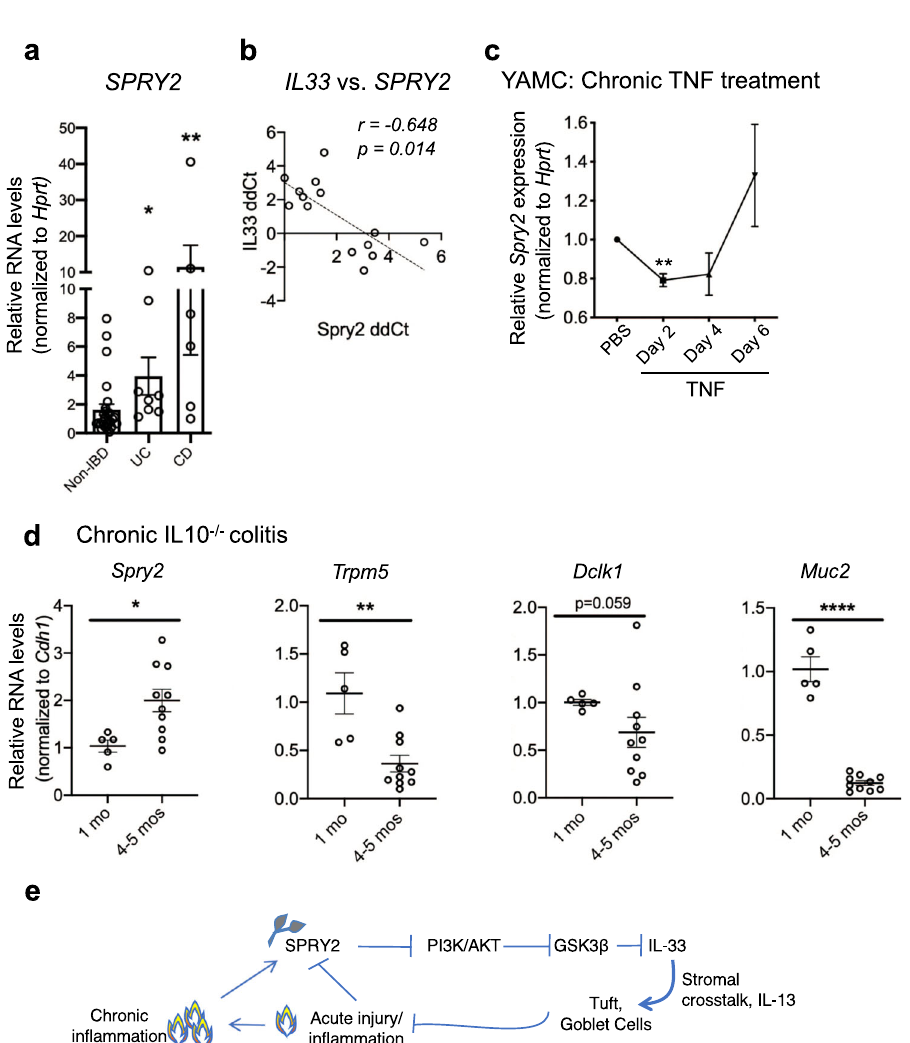
Fig. 8 Sprouty2 is elevated in human IBD, and expression levels negatively correlate with tuft cell markers. a Samples from patient mucosal biopsies from unin fl amed non-IBD ( n = 27), or in fl amed ulcerative colitis ( n = 8) and Crohn ’ s disease ( n = 6), were analyzed for SPRY2 expression; * p < 0.05; ** p < 0.01. Patient characteristics shown in Supplementary Table 1. b Correlation of SPRY2 and IL33 expression levels from IBD patient biopsies (qPCR, plotted as ddCt values). c YAMC cells treated chronically with 100 ng/ml TNF every 2 days for 6 days were measured by qPCR for Spry2 expression; n = 7 independent experiments. ** p < 0.01 versus PBS. d Distal colonic homogenates from IL10 − / − mice before onset of colitis (1 month of age; n = 5) and post- onset of chronic colitis (4 – 5 months of age; n = 10) were assayed by qPCR for Spry2 and markers of tuft and goblet cells. Spry2 , *p = 0.0176; Trpm5 , ** p = 0.0022; Muc2 , **** p < 0.0001. In fi gure, data are presented as mean ± SEM. Analyzed by one-way ANOVA with Dunnett post hoc test, Pearson correlation, or two-sided t test. e Proposed model of Sprouty2 regulation of epithelial IL-33 and secretory cell development in response to colonic in fl ammation: Acute in fl ammation represses Sprouty2 expression in the epithelium. This removes basal inhibition on PI3K/Akt, leading to Akt-mediated inhibition of GSK3 β , promoting epithelial IL-33 expression. Epithelial-produced IL-33 induces IL-13 in the stroma, which in turn signals back to the epithelium to promote tuft and goblet cell expansion as a compensatory mechanism to limit acute in fl ammation and promote injury resolution. Loss of this dynamic differentiation mechanism in the setting of chronic in fl ammation might potentiate disease